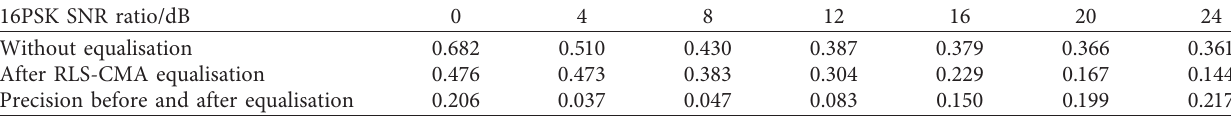
Table 6: Error vector amplitude accuracy values obtained for the 16PSK-modulated signals before and after RLS-CMA equalisation. 16PSK SNR